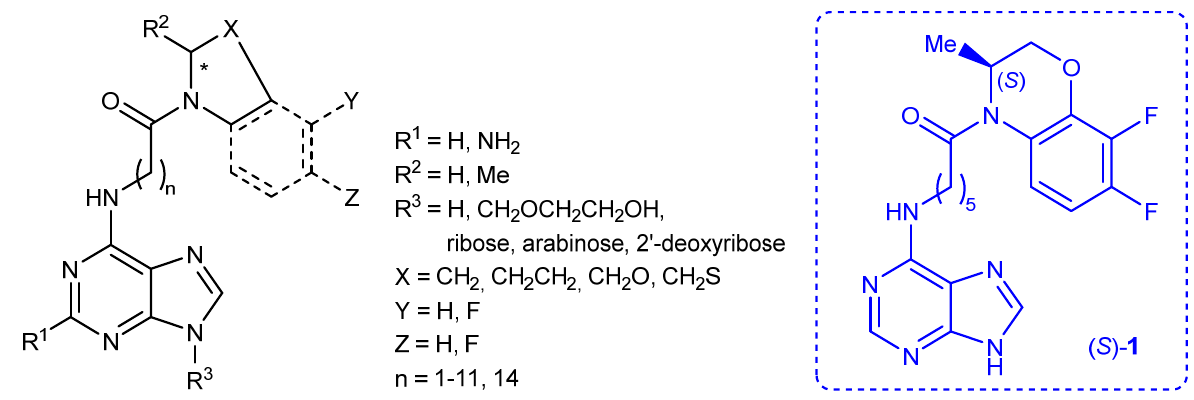
Figure 2. Structures of the previously obtained purine conjugates with N -heterocycles.